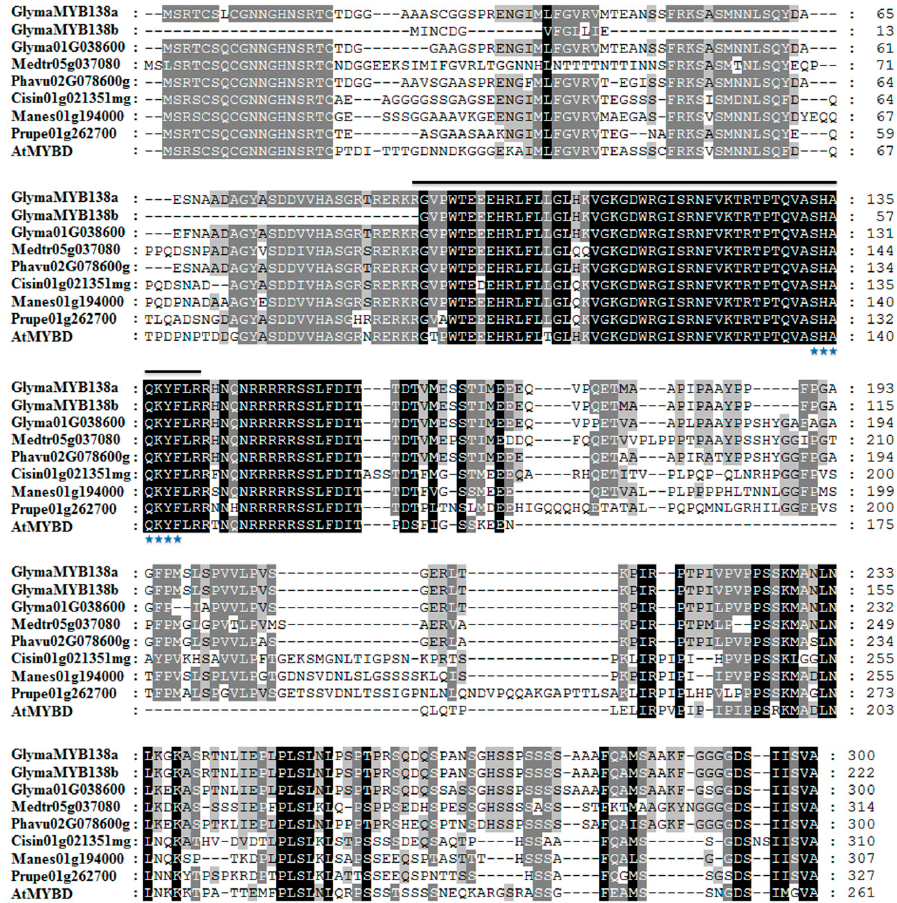
Figure 5. Multiple sequence alignment of deduced amino acid sequence of GmMYB138a with its homologs in different species. Amino acid sequences were aligned by ClustalW, and imported in Genedoc for shading. Identical amino acid residues are shown in black. If the conserved percent was up to 80% and 60%, the amino acid residues were shaded with gray and light gray colors, respectively. The MYB domains of CCA1-like proteins are indicated by lines. The consensus sequence SHAQK(Y/F)F is marked with stars.